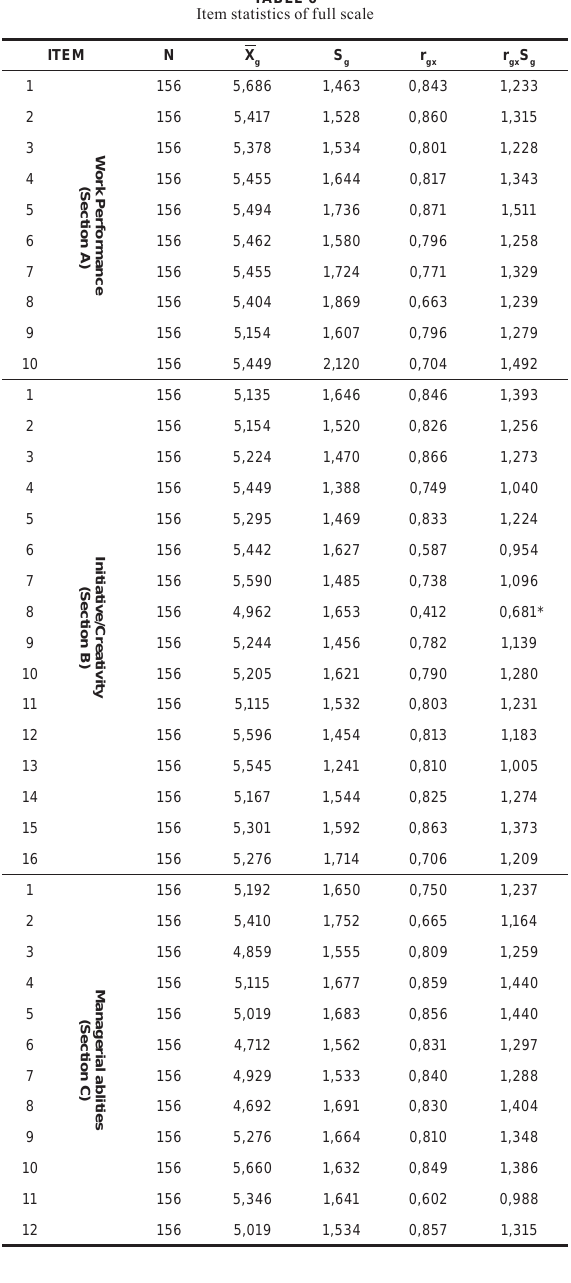
TAbLE 6 Item statistics of full scale